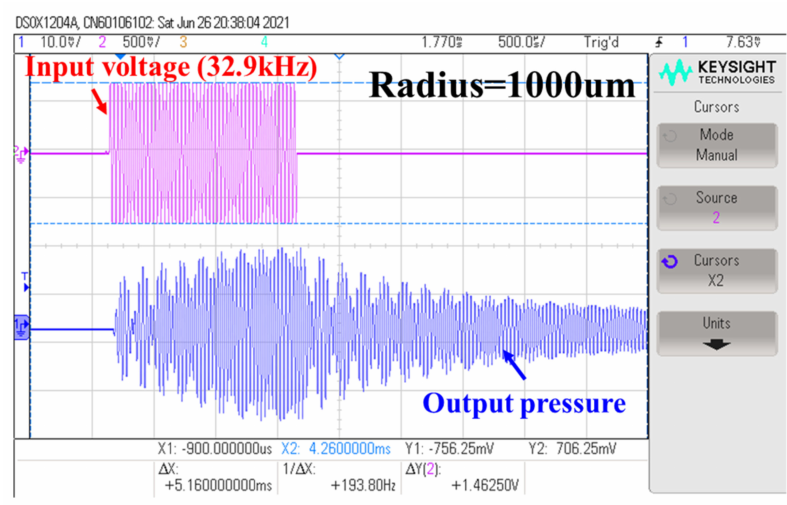
Figure 10. Acoustic pressure measurement of the